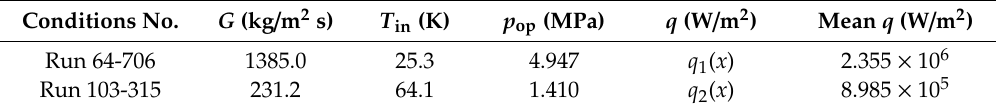
Table A1. Main parameters of two experimental conditions, Run 64-706 and Run 103-315.